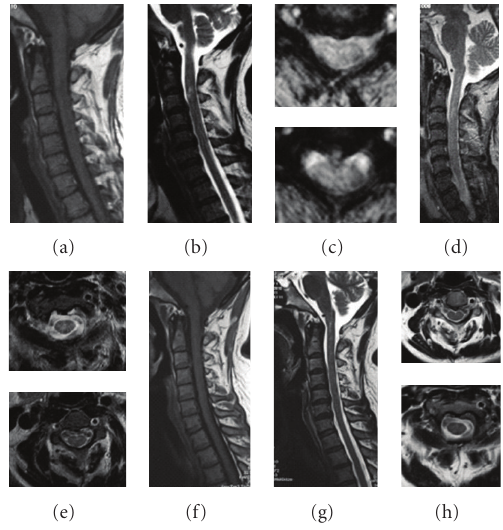
Figure 4: A 51-year-old female su ff ered from tetraparesis and frequently paroxysmal tics of extremities for 3 months. ATT treatment quickly improved her symptoms. After 2-year ATT, she fully recovered without visible symptoms. The MRI changes are as follows: (a) sagittal T1-weighted MRI showing focal thickening of the cord at C2-C3 level, (b) sagittal T2-weighted MRI showing a focal demyelinating lesion, (c) axial T2-weighted MRI showing the lesion to involve the whole cord, (d) sagittal T2-weighted MRI after 6 months of treatment, showing the swelling of the cervical spinal cord and patchy abnormal signal have resolved, (e) axial T2-weighted MRI showing an abnormal signal remains, (f) sagittal T1-weighted MRI after 2 years of treatment is normal, (g) sagittal T2-weighted MRI after 2 years of treatment revealing no abnormal signals, and (h) axial T2-weighted cord MRI after 2 years of treatment.